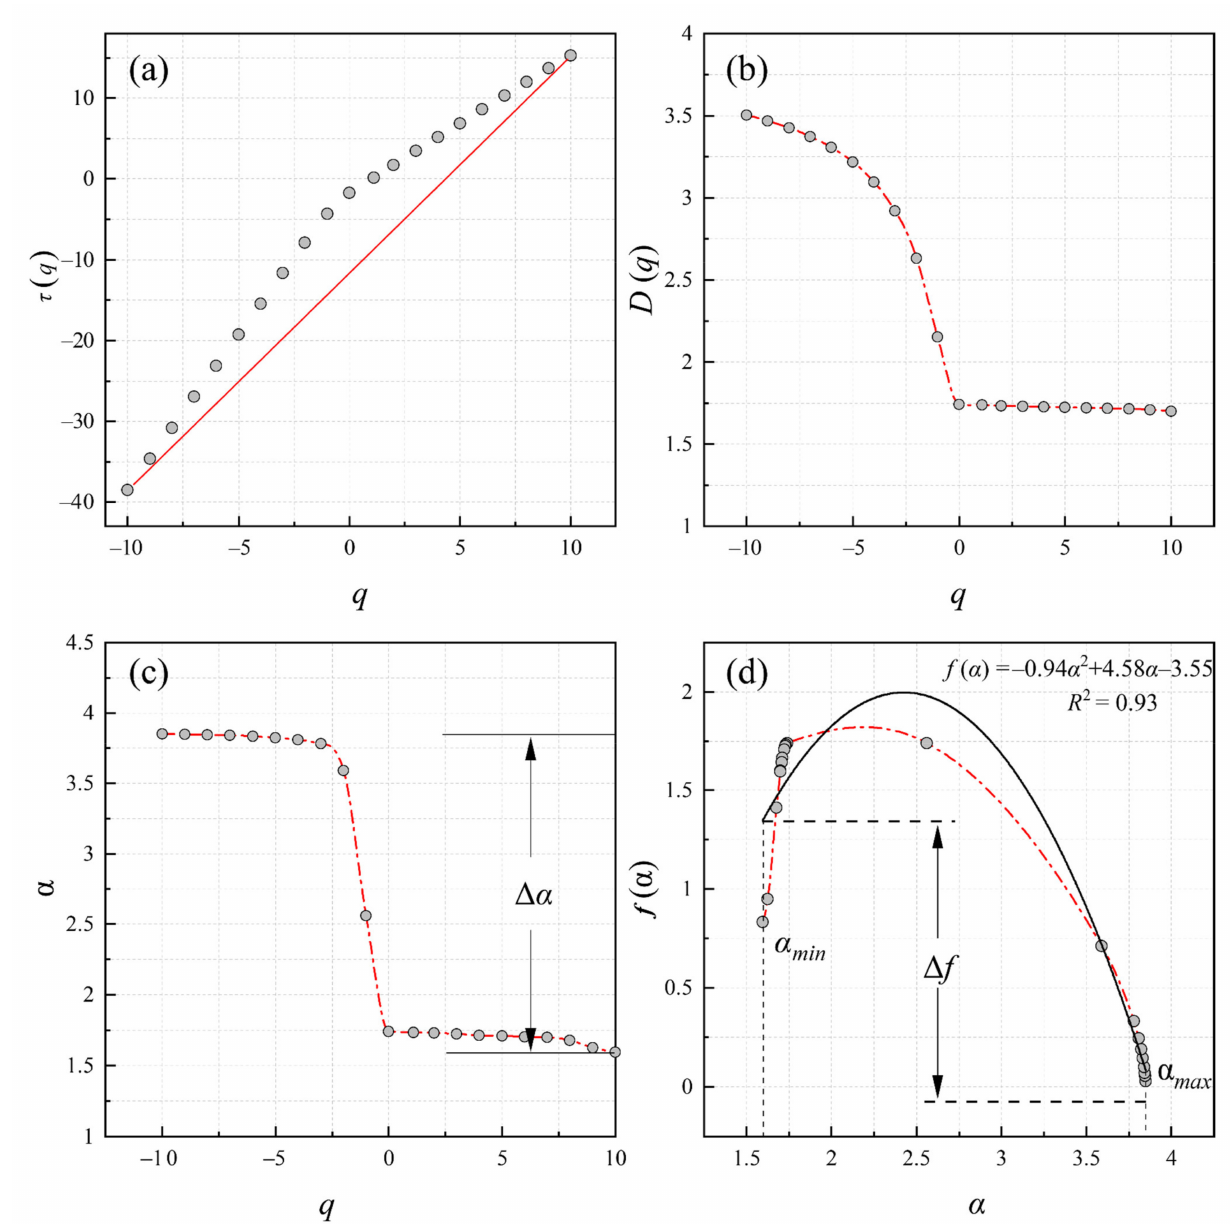
Figure 8. Multifractal analysis of lineaments in the Qianhe Graben. ( a ) Diagrams of τ ( q ) and q , where the red line has no practical significance and only represents the τ ( q ) changes with q when there is no deviation; ( b ) diagram of D ( q ) and q ; ( c ) diagram of α and q ; ( d ) the red line is the original multifractal spectrum f( α )- α , and the black line is the fitted fractal